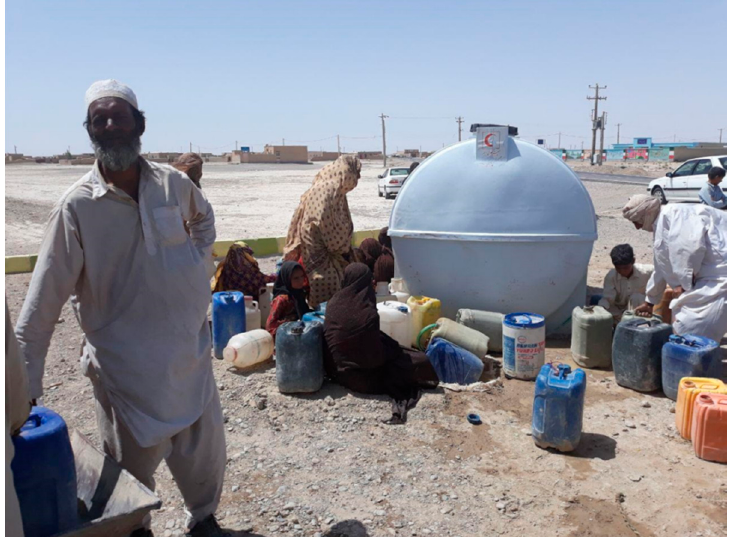
Figure 4. Regional government campaigns to transport water with tanker trucks to areas with water shortages (http://tnews.ir/site/1ce7117663375.html?refc=36).